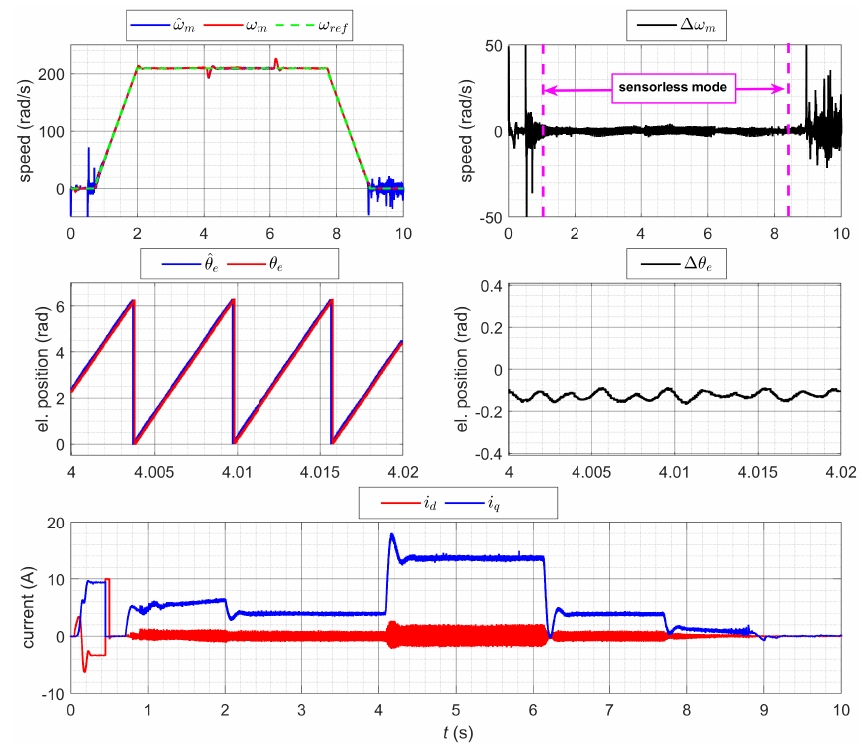
Figure 4. Experimental results for speed and position estimation with saturation function, E max = 20.